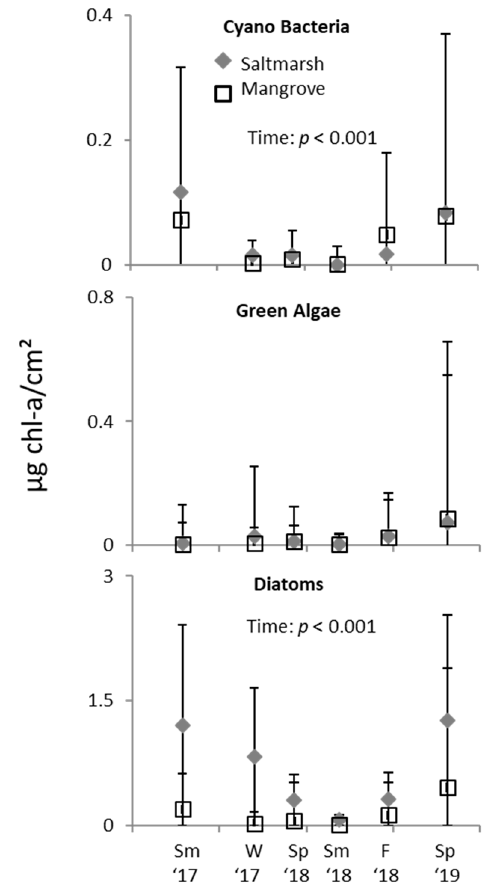
Figure 3. Benthic algae biomass in saltmarsh and mangrove habitat observed over the two-year predator exclusion experiment. Significant results are displayed in the inset panel. Since there was no treatment effect, data from control and predator exclusion plots were combined. Data are shown as the mean ± SEM for 10 replicate plots per habitat type.